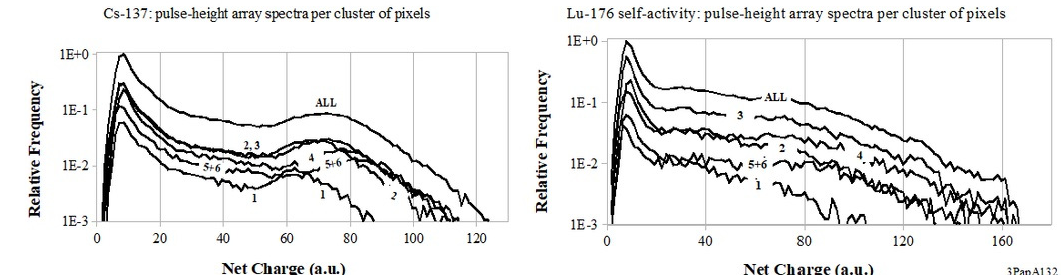
Figure 2. Semilog plots pulse-height spectra per cluster of pixels from Cs-137 ( left ) and Lu-176 self-activity ( right ) data. Total spectra of the array are drawn (topmost curves) together with the ones of clusters from 1 to 5 + 6.